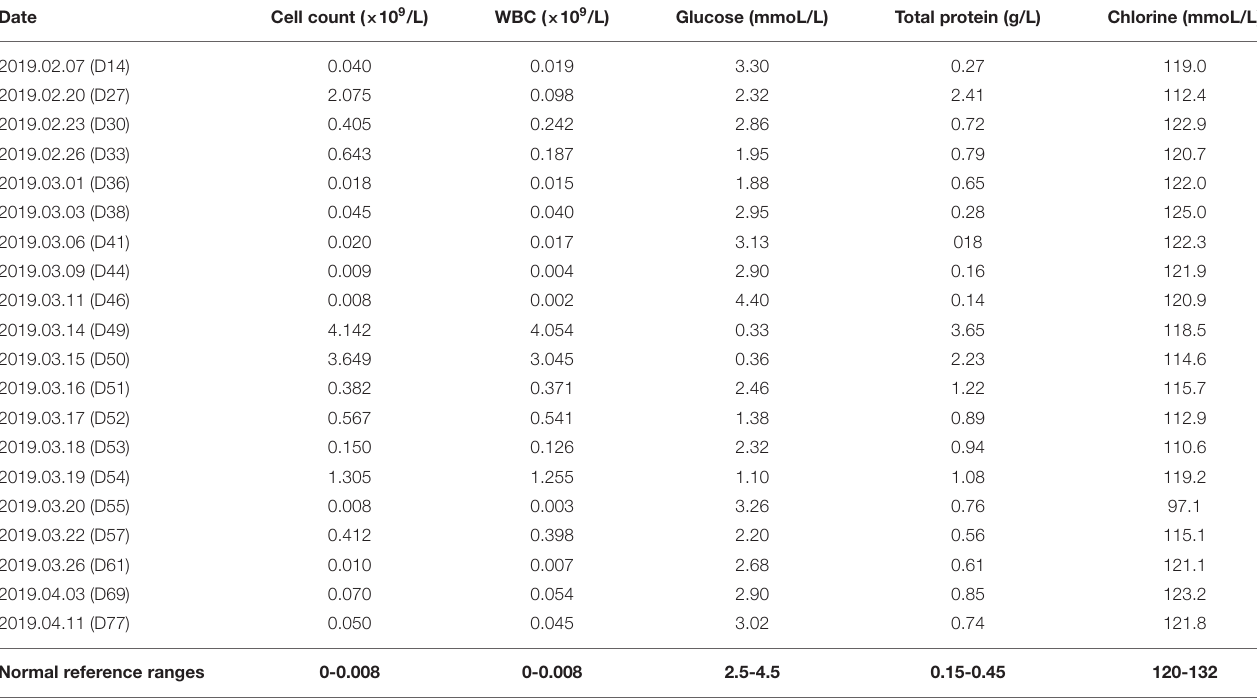
TABLE 1 | Laboratory tests for cerebrospinal fuid over the course of treatment.